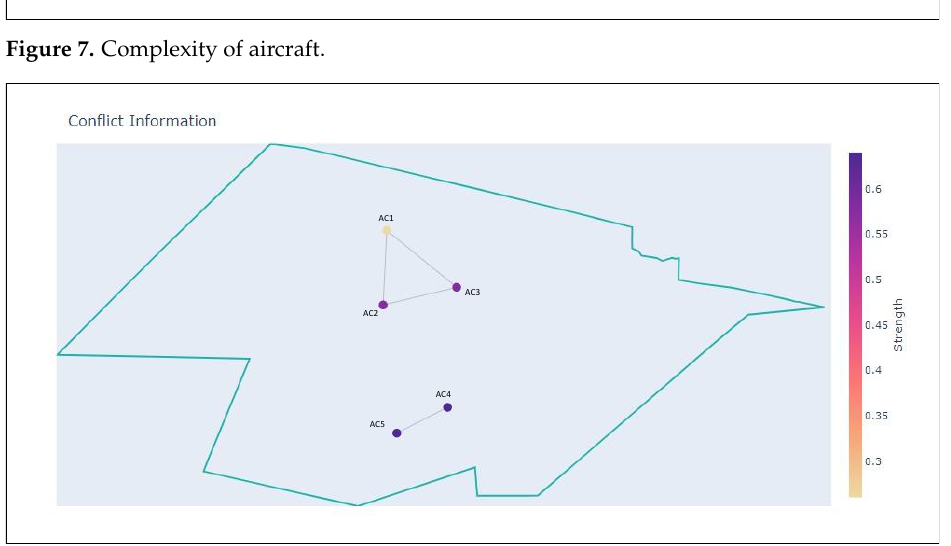
Figure 8. Conflict